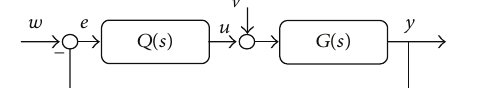
where parameters of polynomials and 𝑞(𝑠) are computed from